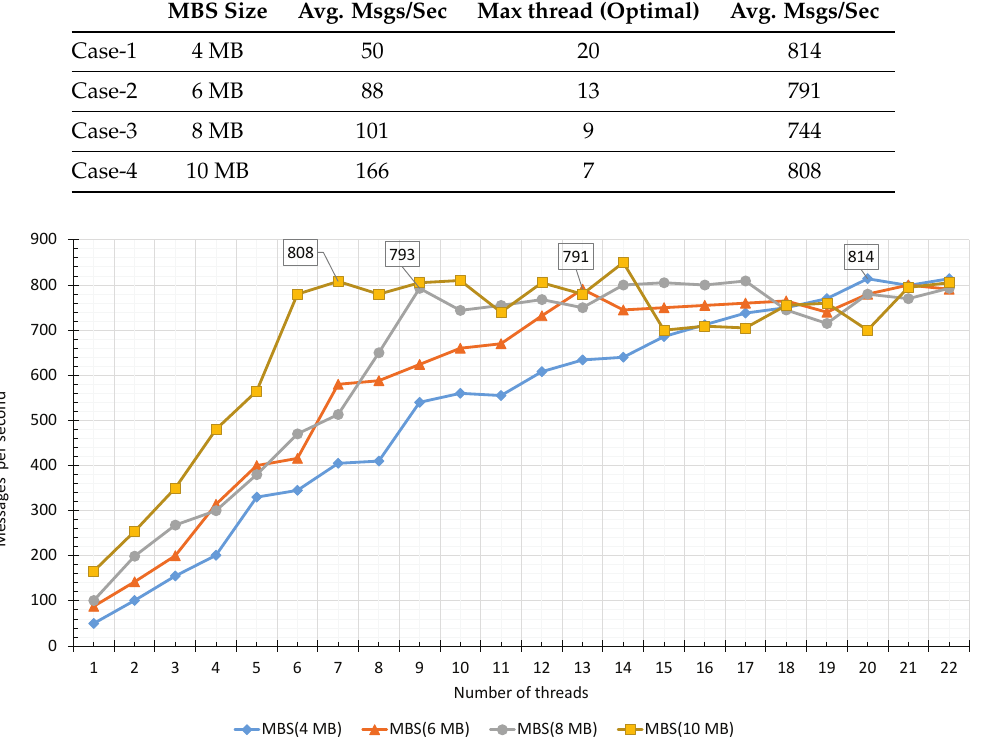
Figure 17. Performance testing of